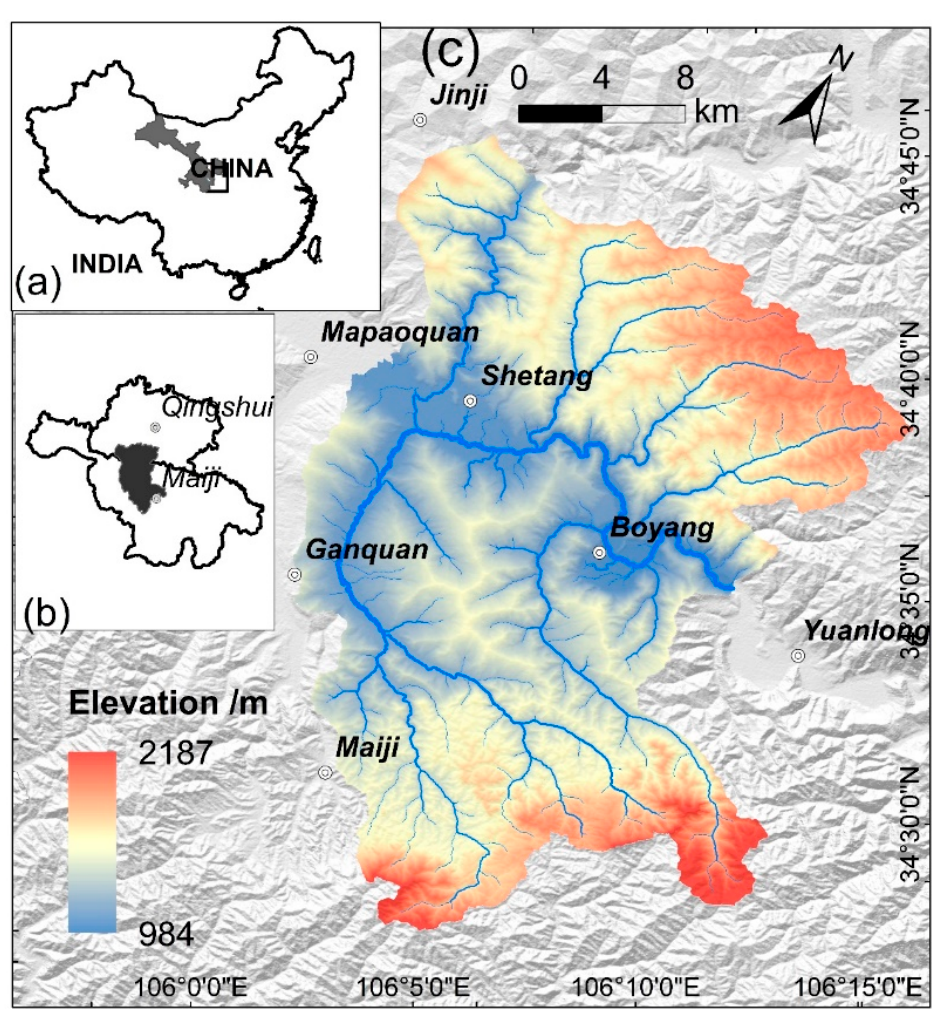
Figure 1. Map showing the location of the study area and its topography: ( a ) Gansu Province. ( b ) The location of Tianshui. ( c ) The distribution of elevation and the main rivers in the study area.